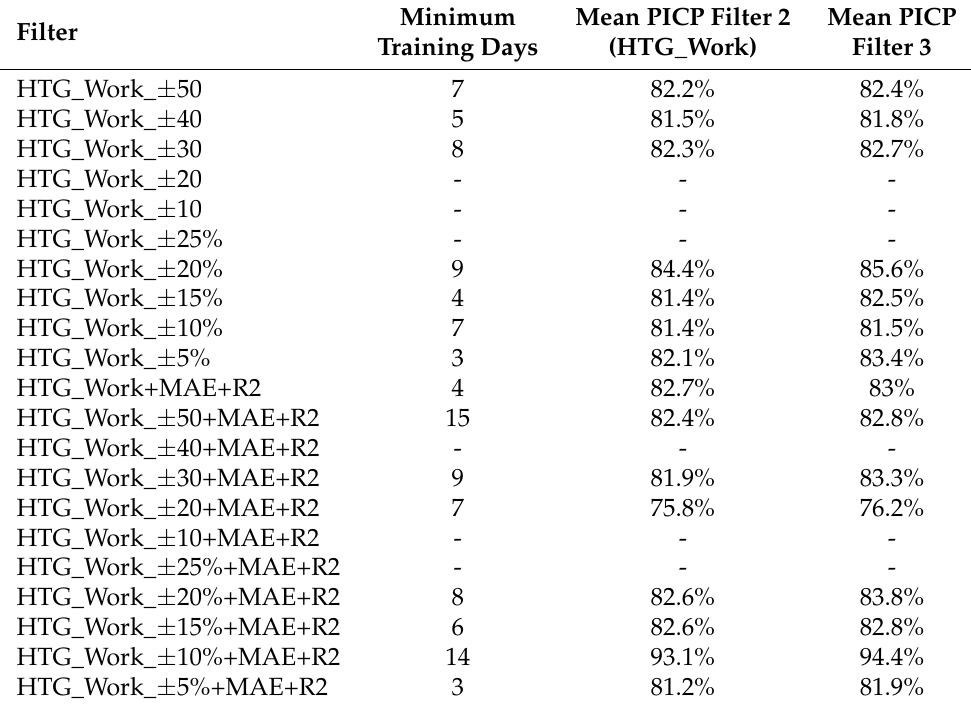
Table 3. Minimum training days required by each